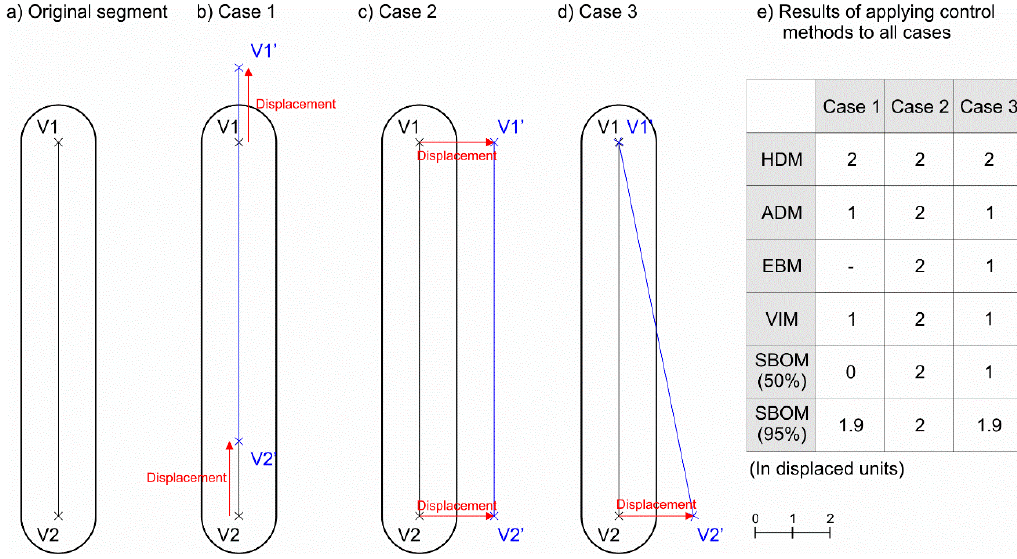
Figure 2. Examples of displacements applied to a segment.